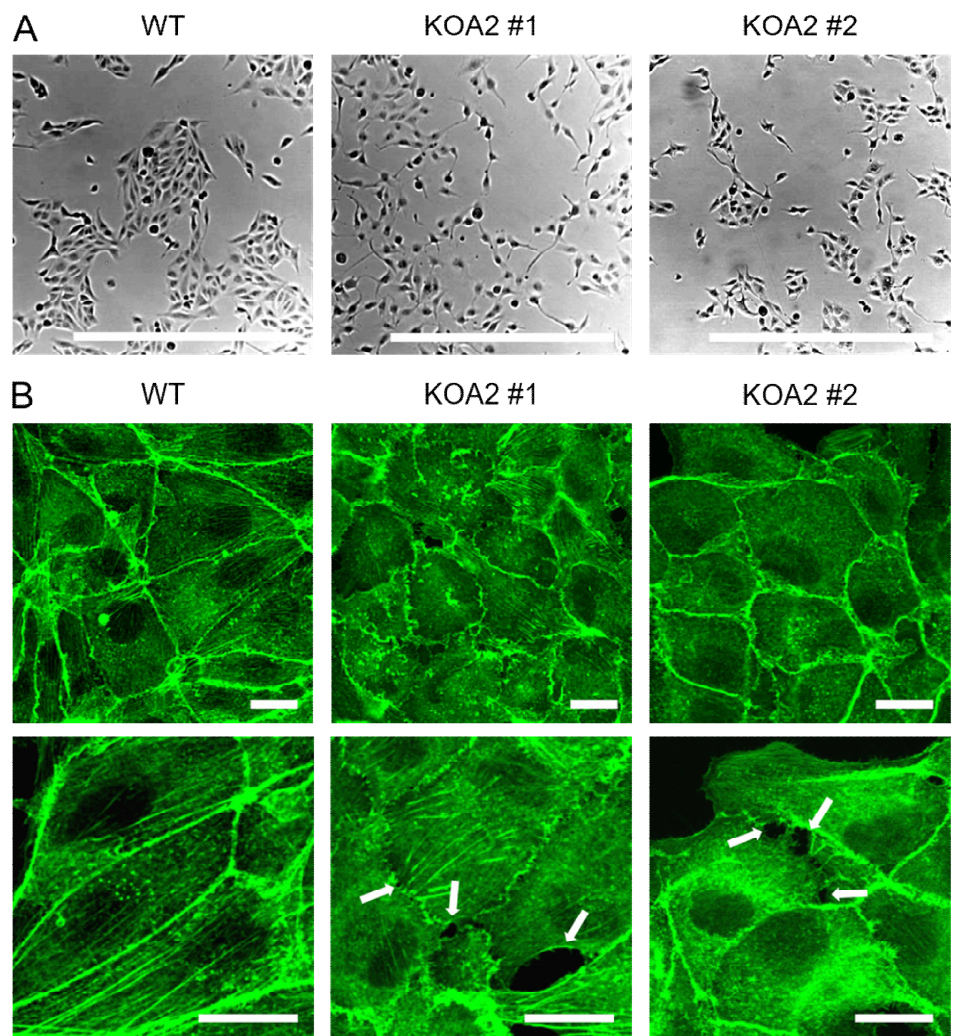
Figure 3. Distinct morphologies of the wild-type and SLC35A2-deficient MDCK cells. ( A ) General morphology of the wild-type cells and SLC35A2 knockout clones showed by transmitted light micrographs. Scale bar corresponds to 500 µ m. ( B ) The results of F-actin staining using fluorophore-conjugated phalloidin. The upper panel contains images obtained at a lower magnification, whereas the lower panel contains images obtained at a higher magnification. The sites of local disruption of cell–cell contacts in the knockout clones are indicated with arrows. Scale bar corre- sponds to 20 μm.